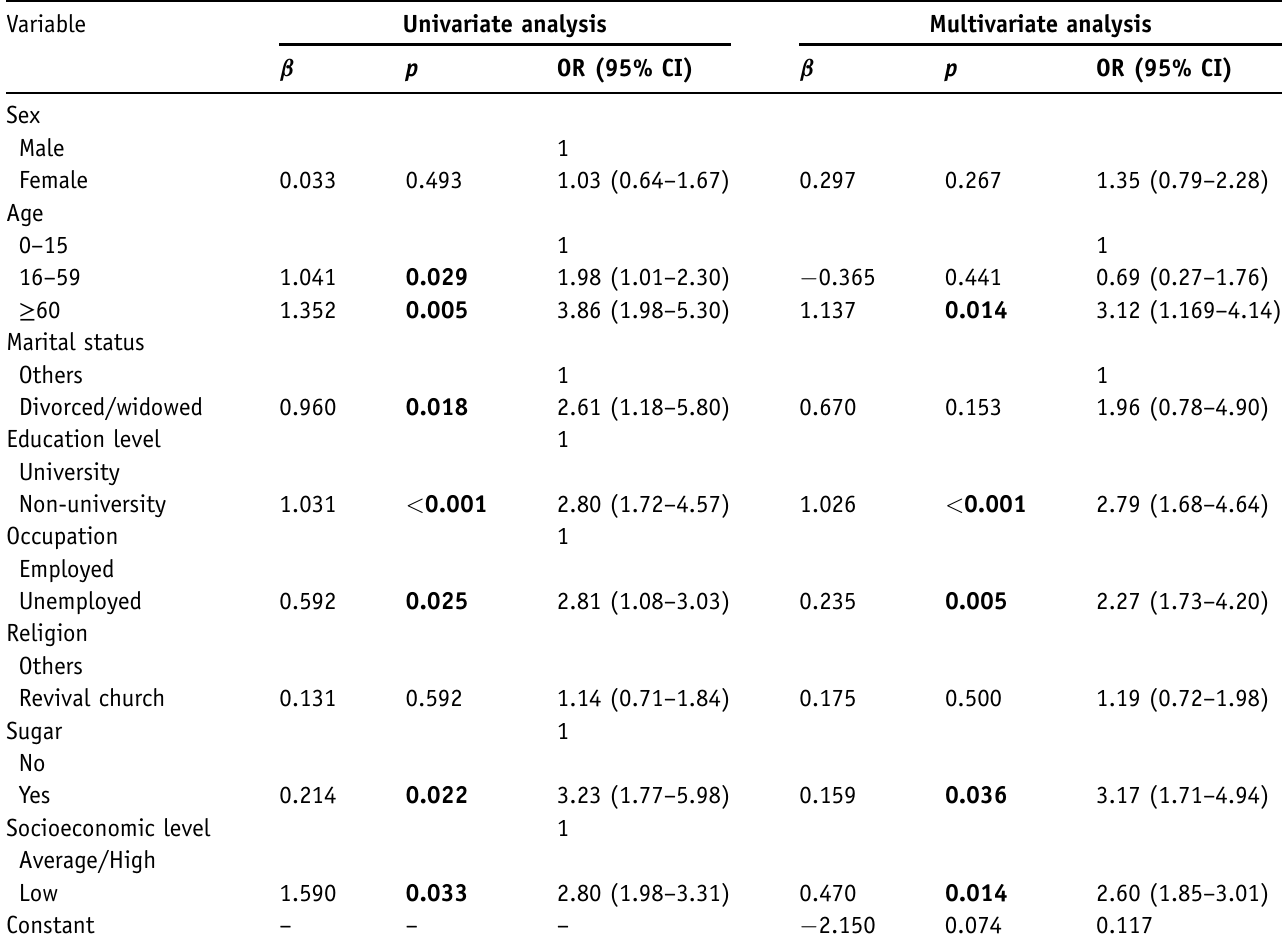
Table 2. Sociodemographic factors associated with dental